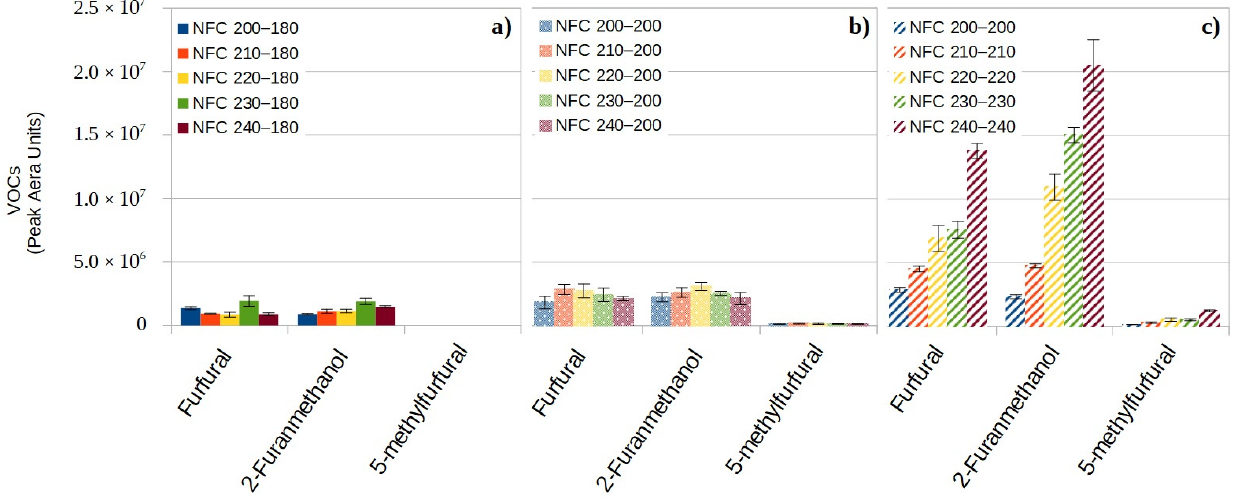
Figure 5. VOCs coming from the dehydration of the primary holocellulose decomposition products, Furfural, 2-Furanmethanol and 5-methylfurfural, as a function of molding temperature conditions for a core temperature of ( a ) 180 °C, ( b ) 200 °C and ( c ) going from 200 °C to 240 °C.